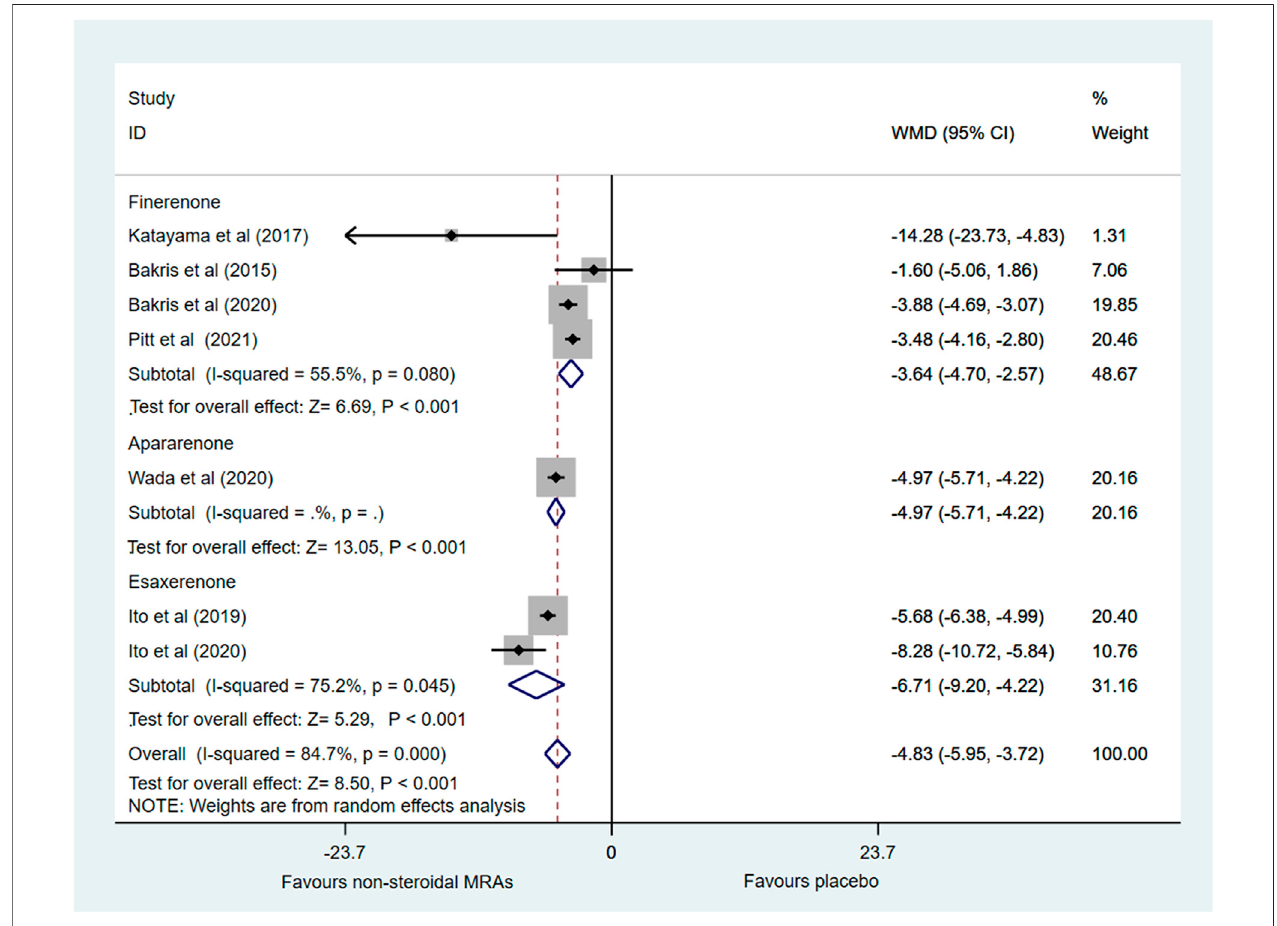
FIGURE 5 | Forest plot for the effect of non-steroidal MRAs on the changes in SBP from baseline in patients with CKD and T2D. SBP, systolic blood pressure (expressed in mmHg); WMD, weighted mean difference; MRAs, mineralocorticoid receptor antagonists; CKD, chronic kidney disease; T2D, type 2 diabetes.